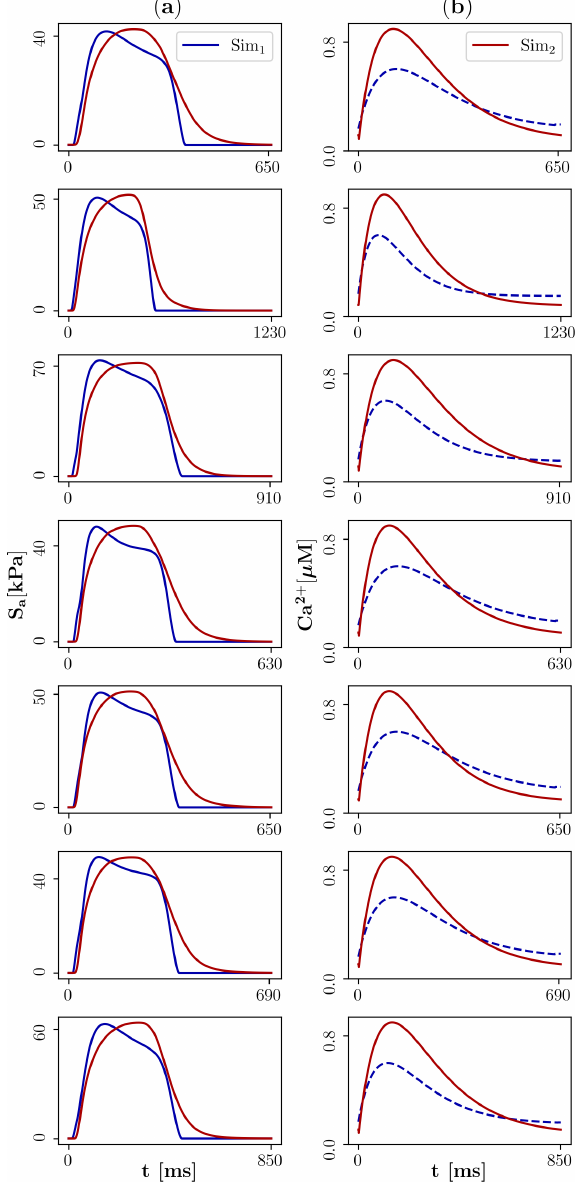
Figure 5. Comparison of simulated cellular active stress and intracellular calcium concentration. The blue lines represent the median nodal traces obtained from the simulations that were produced by the 3D model of human left ventricular EM in the first step (Sim 1 ). The red lines represent the traces that were produced by the 0D model of cellular EM in the second step of the active mechanics personalisation approach (Sim 2 ). ( a ) Cellular active stress traces (solid line represents a target for the personalisation), ( b ) intracellular calcium concentration traces (dashed line does not represent a target for the